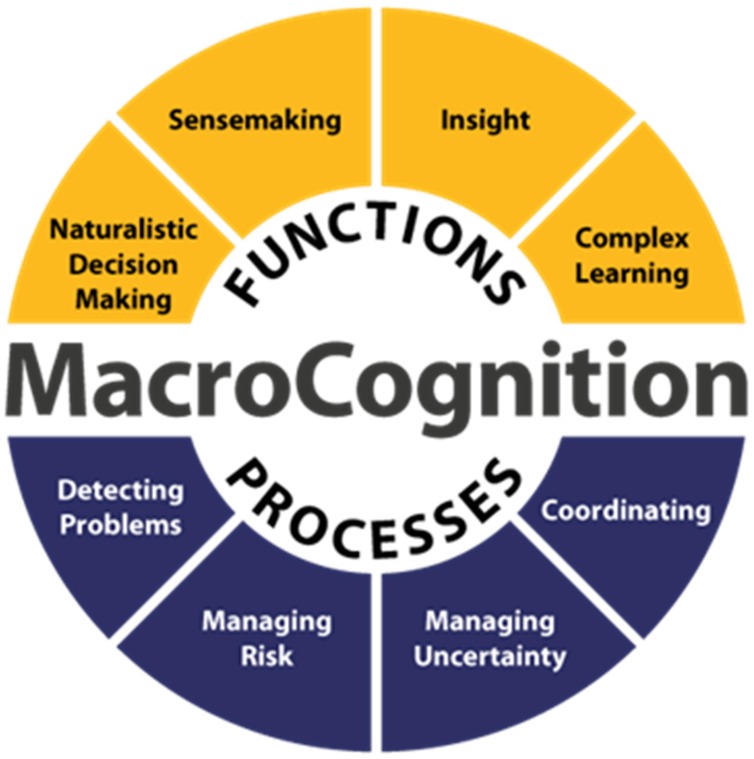
Processes and functions in macrocognition [from Schraagen et al., 2008].